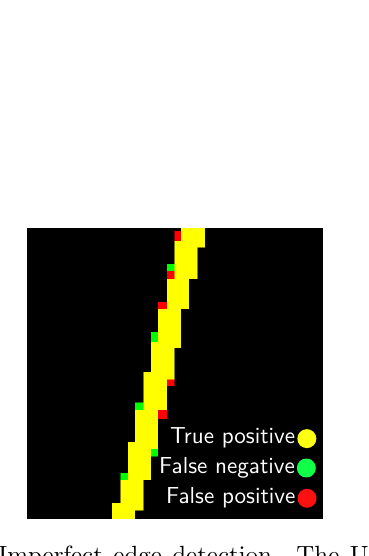
Figure 13: Imperfect edge detection. The U-Net pre- diction of the laser line is often incorrect at the edges of the laser line.